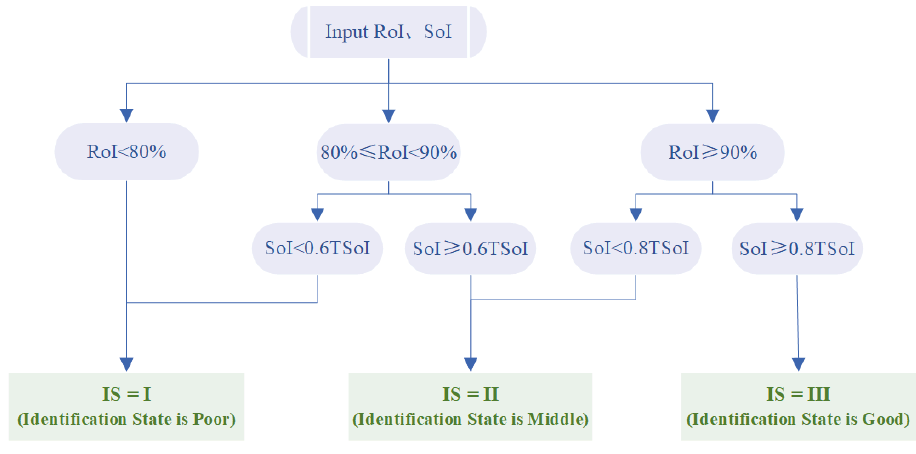
Figure 6. Classification of the IS.